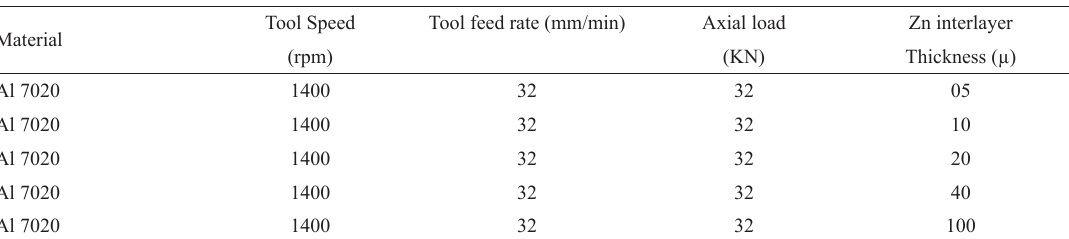
Table 3: FSW process parameters used in this